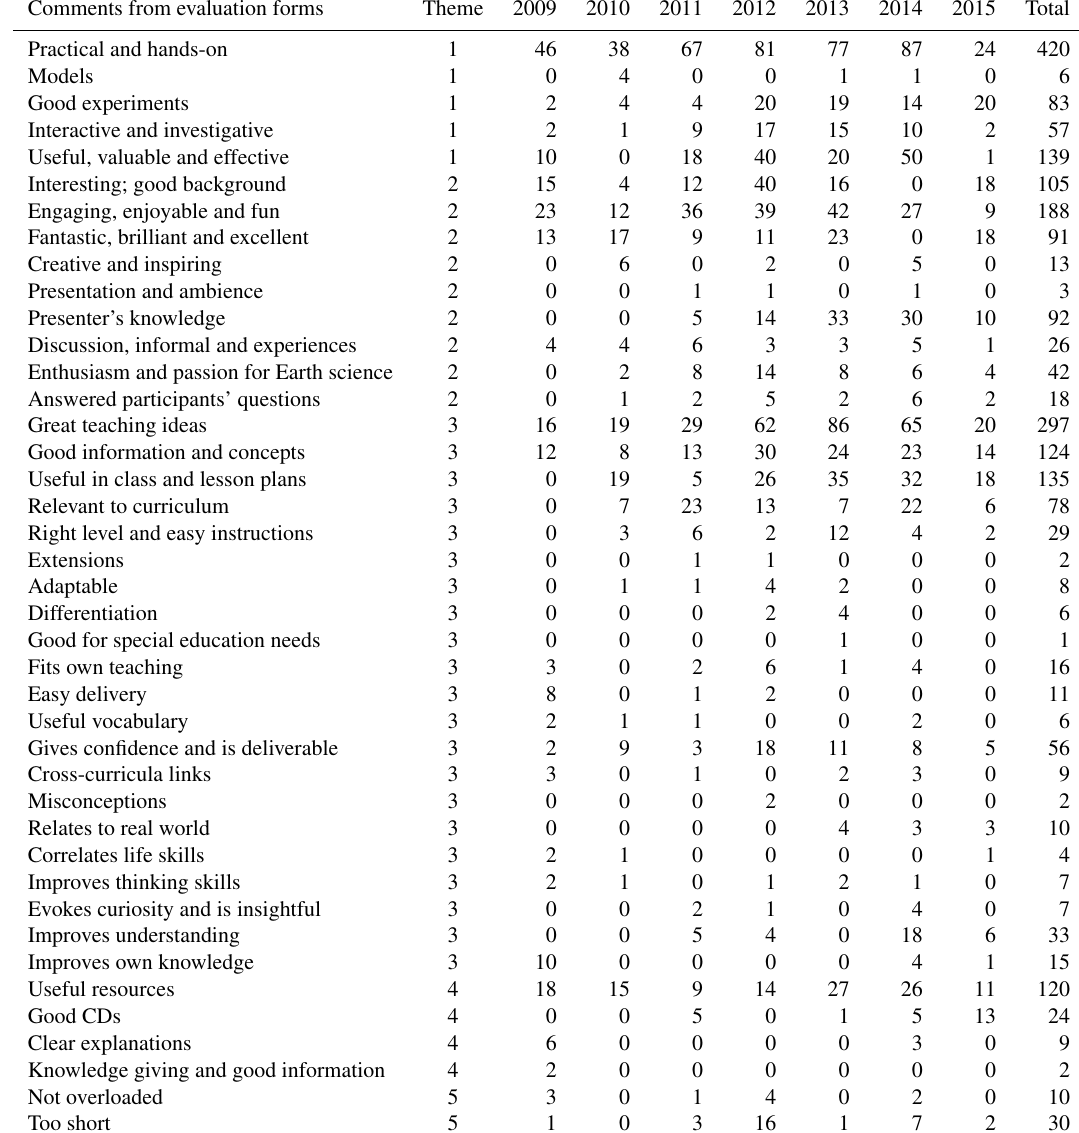
Table 4. Composite table of comments and themes from participants about ESEU CPD workshops